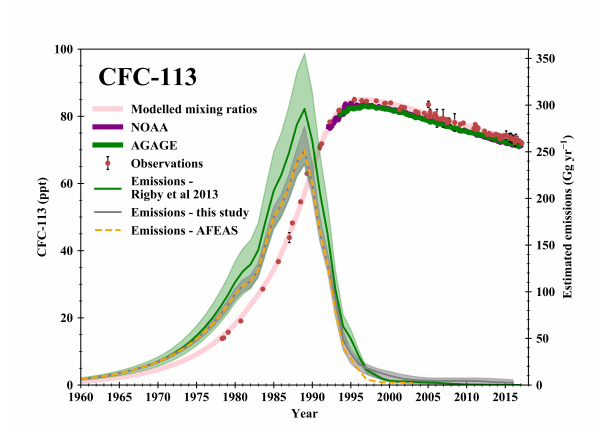
Figure 5. CFC-113 emissions from this study, AFEAS and Rigby et al. (2013), and CFC-113a emissions from this study 1995–2016 with